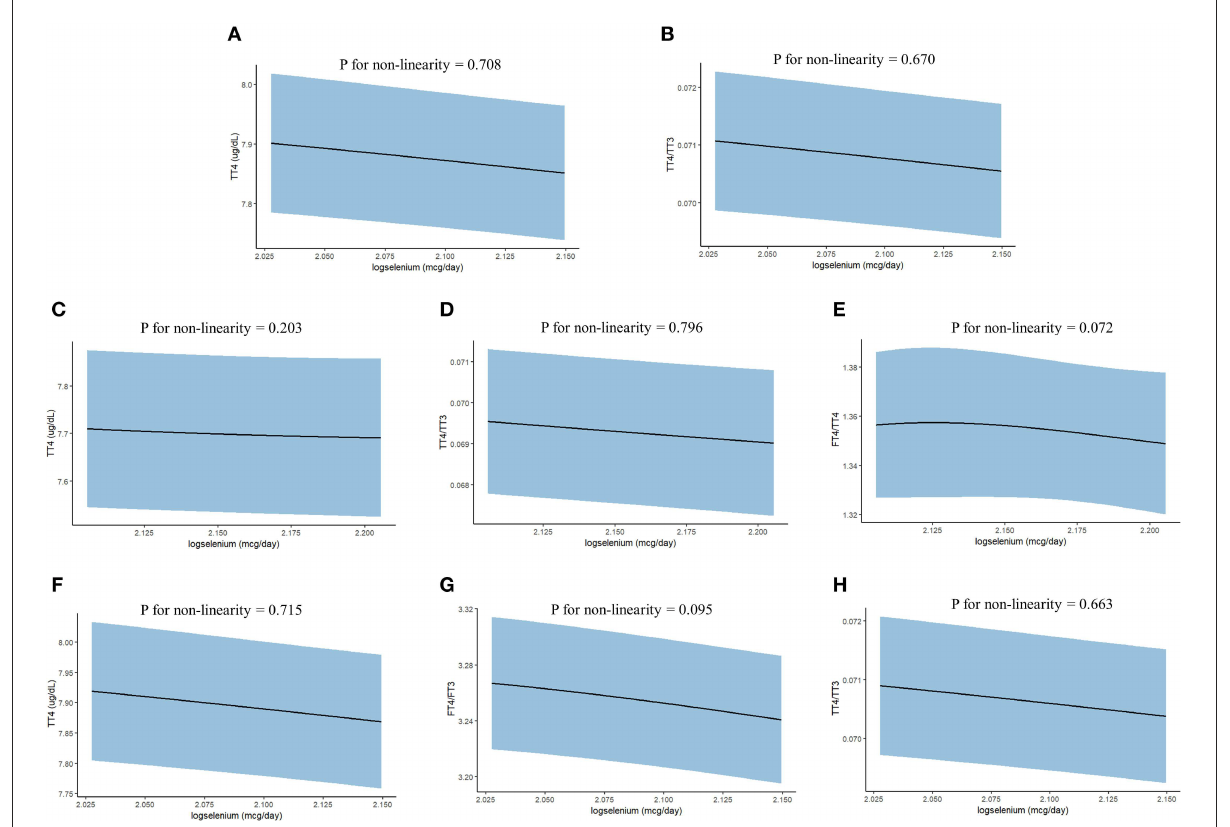
FIGURE2 The dose-response relationship between dietary selenium intake and thyroid hormones in the whole and subgroup adults from NHANES 2007–2012. (A) TT4 of whole adults; (B) TT4/TT3 of whole adults; (C) TT4 of male adults; (D) TT4/TT3 of male adults; (E) FT4/TT4 of male adults; (F) TT4 of iodine-sufficient adults; (G) FT4/FT3 of iodine-sufficient adults; and (H) TT4/TT3 of iodine-sufficient adults. Point estimates (solid line) and 95% confidence intervals (blue area) were estimated by restricted cubic splines analysis with knots placed at the 5th, 25th, 50th, 75th, and 95th percentile. Models were adjusted for sex, age, race, education level, household income, marital status, BMI, serum cotinine level, drinking, urine iodine concentration, and fasting